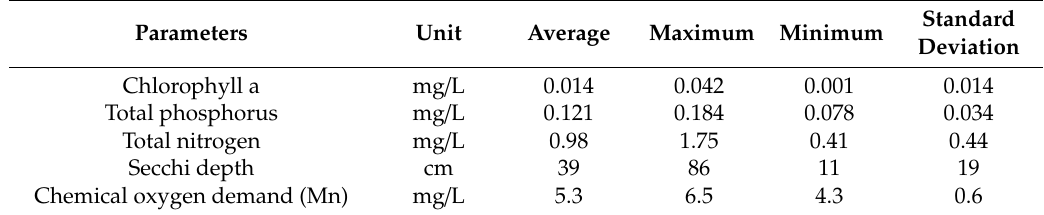
Table 1. The monitoring data from January to November 2019.